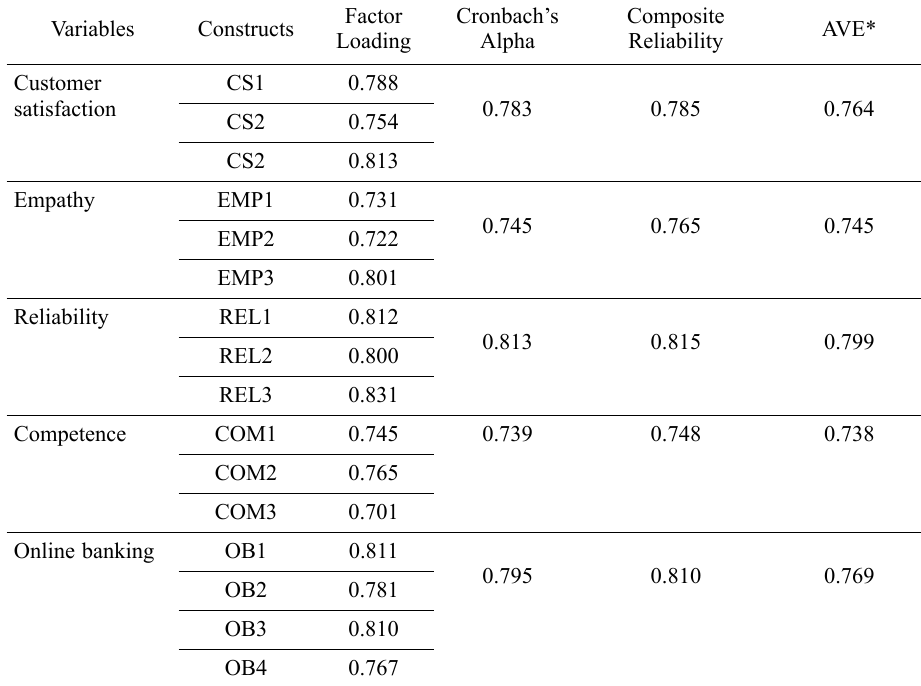
Table 1. Factor loadings and